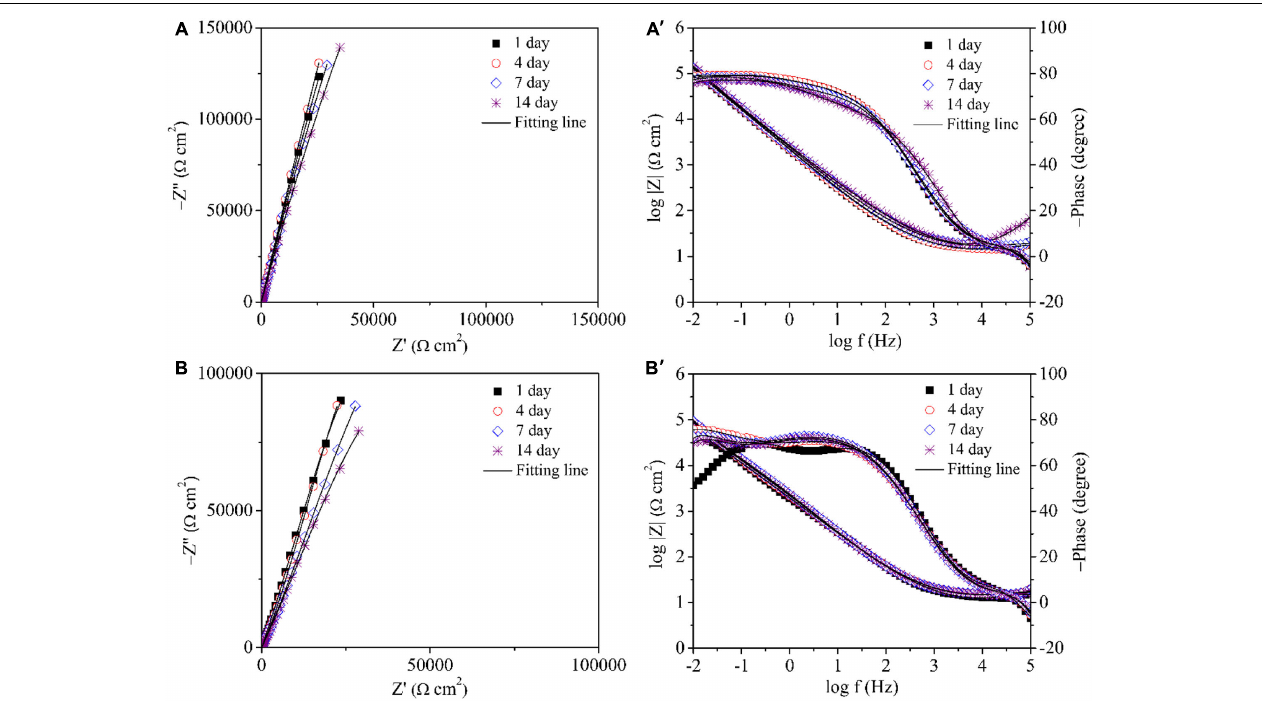
FIGURE 8 | Nyquist and Bode plots for the coupons during the 14 days of incubation with and without P. aeruginosa : (A,A (cid:48) ) abiotic control and (B,B (cid:48) ) inoculated with P. aeruginosa .